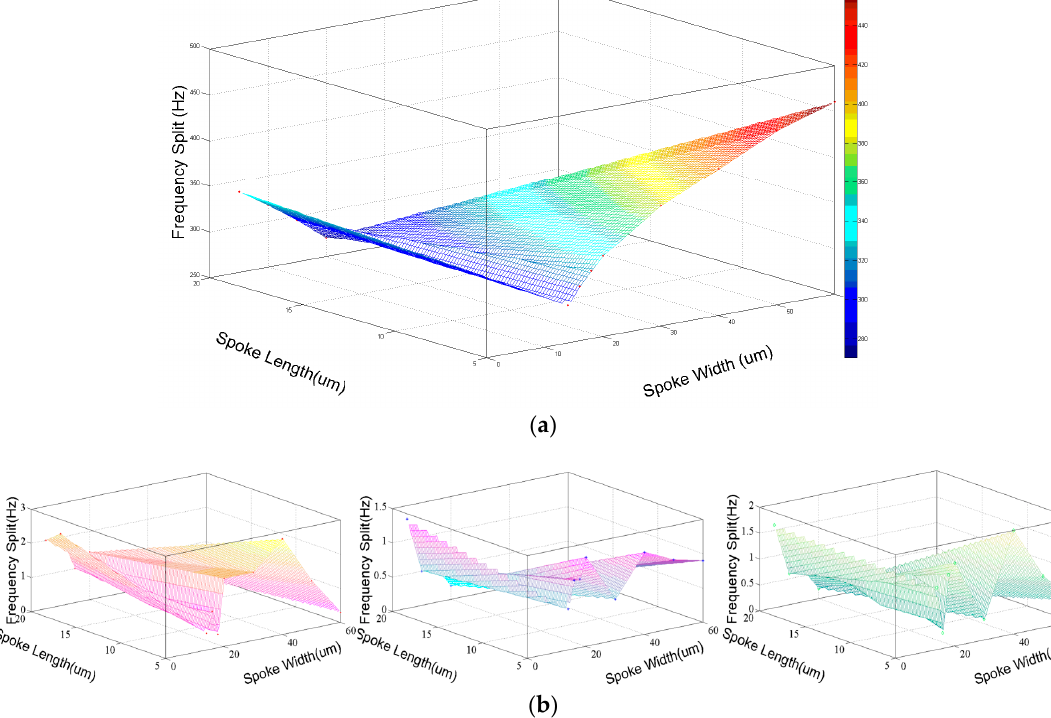
Figure 4. Relationship between the frequency splits and different length and width of spokes: ( a ) <100> DRG in n = 2, ( b ) From left to right: <111> DRG in n = 2, <100> DRG in n = 3, <111> DRG in n = 3.